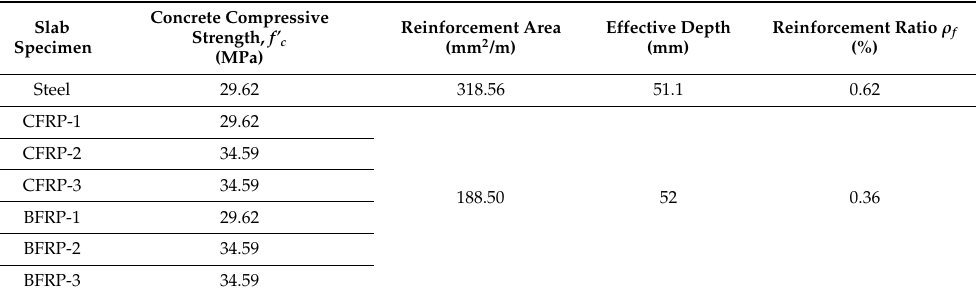
Table 2. Compressive strength of concrete and details of